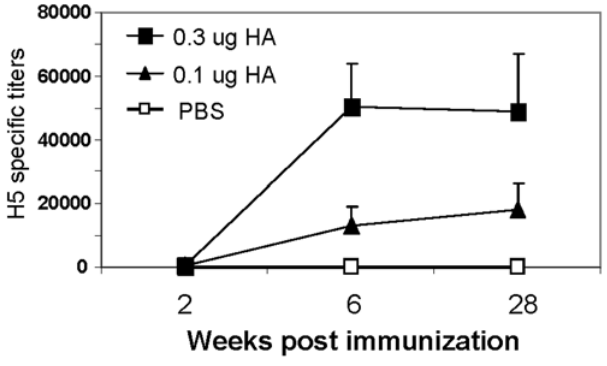
Figure 4. Long-term maintenance of IgG antibodies specific to influenza H5N1 virus. Serum samples collected at week 2 post priming (week 2), at week 2 post boosting (week 6), and at week 28 before challenge infection were used to determine antibody levels specific to H5N1 virus by ELISA with whole H5N1 inactivated virus antigen. Antibody titers are shown as described in Materials and methods, and error bars indicate standard deviation (n=6).